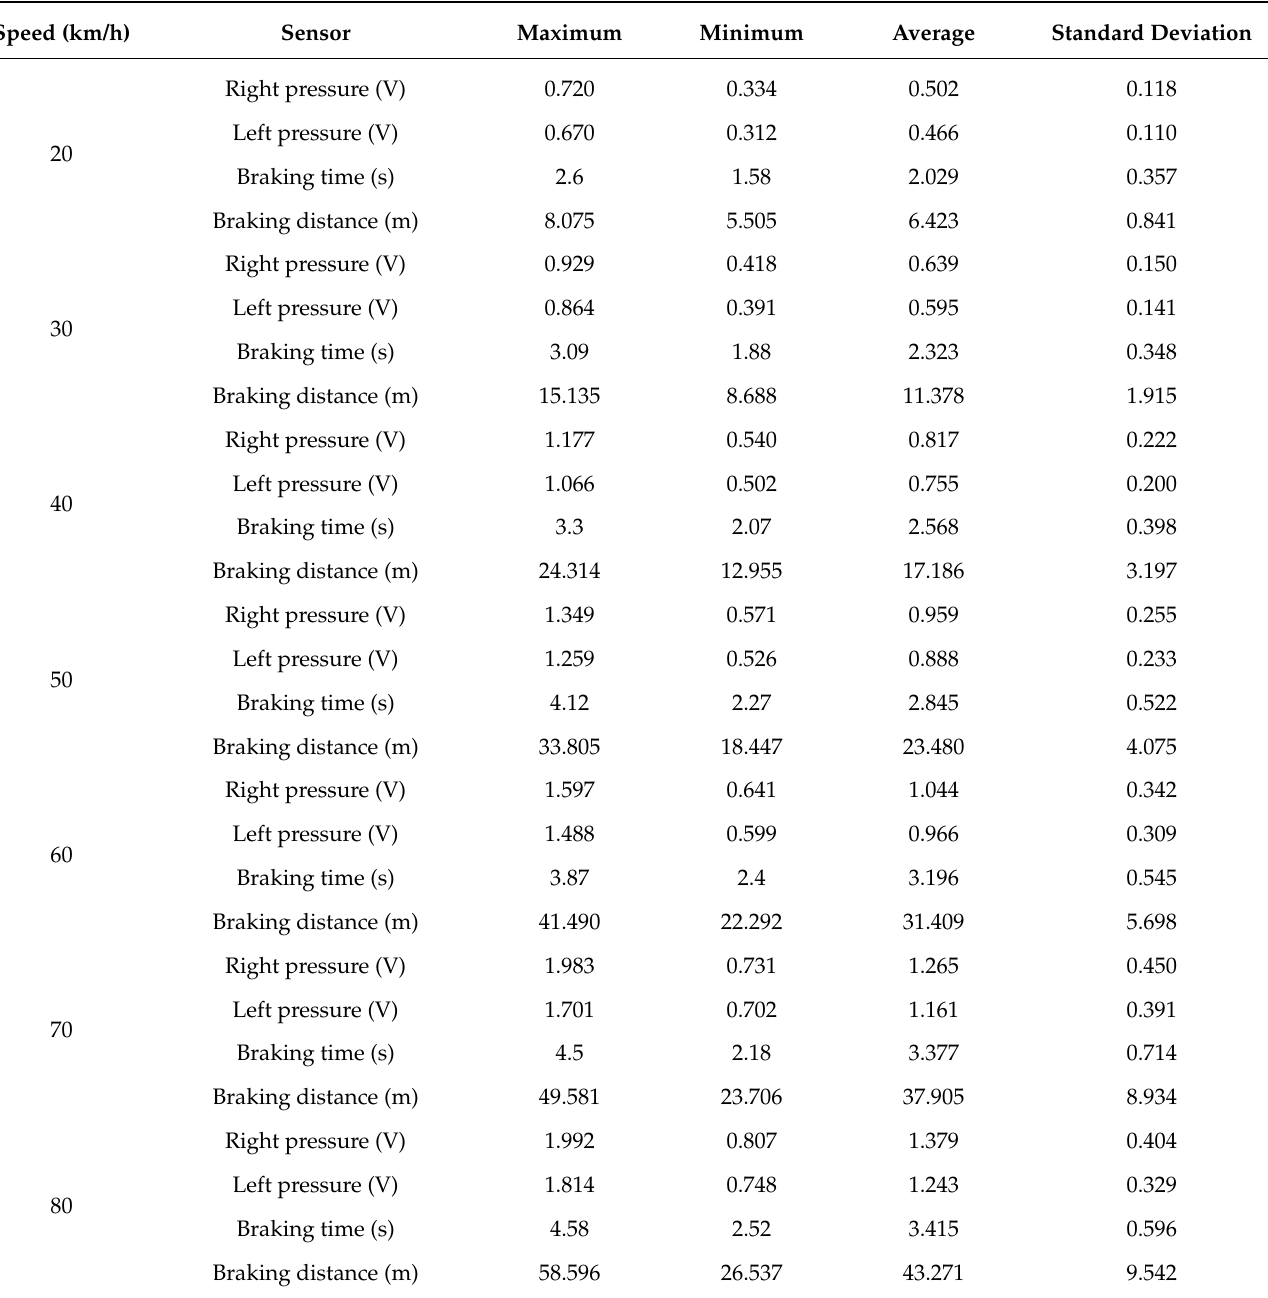
Table 3. Data from variables analysed for each test speed for progressive